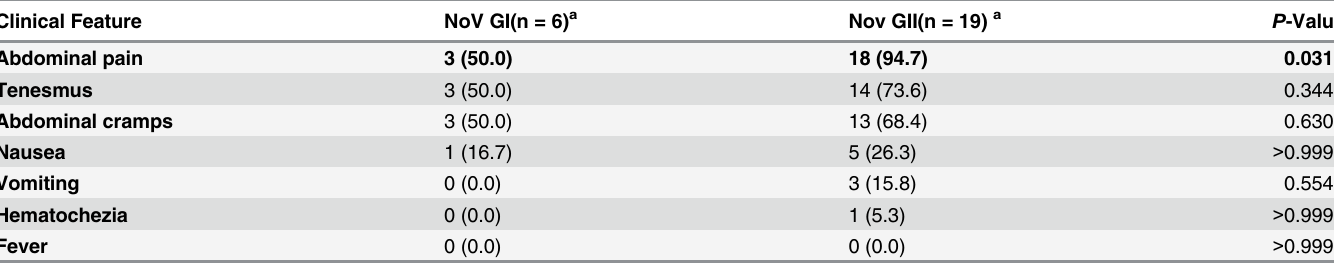
Table 5. Clinical features in diarrhea cases with GI versus GII norovirus, no. (%). Clinical